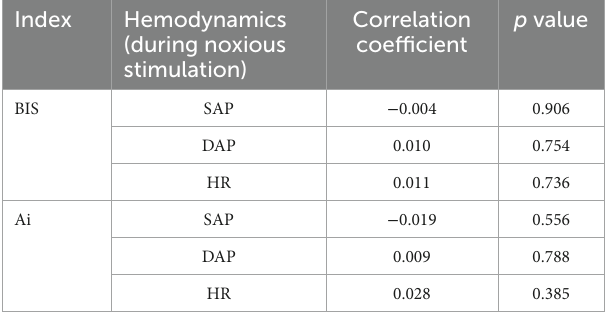
TABLE 4 Correlation analysis of Ai and BIS with hemodynamics during noxious stimulation. Index